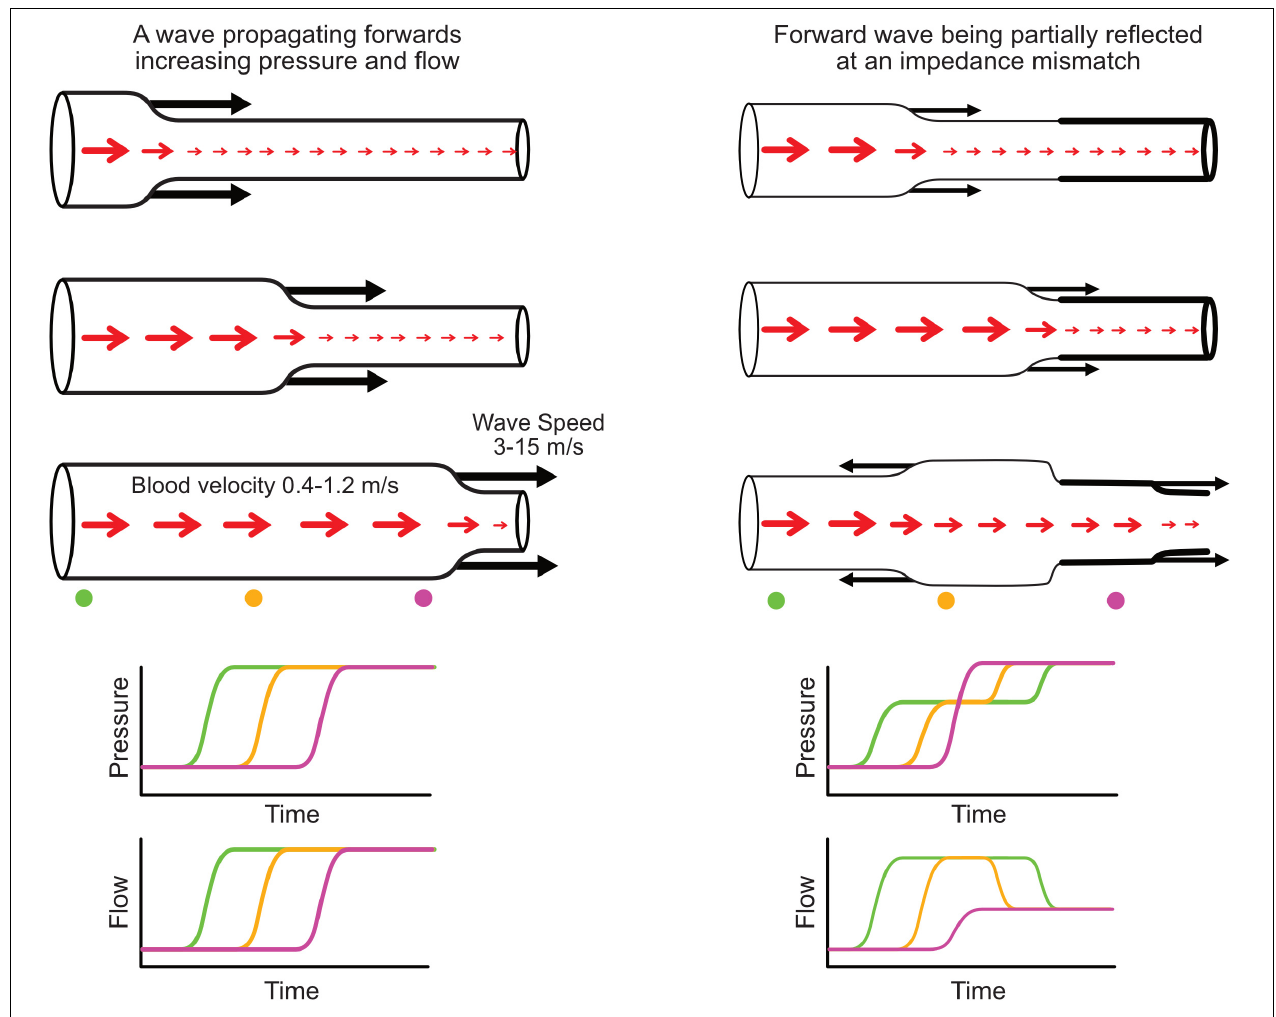
FIGURE 1 | (Left) Illustration of a forward-propagating wave that increases pressure and flow. (Right) A forward-propagating wave encounters an impedance mismatch (increased vessel stiffness indicated by thicker wall) and is partially transmitted and partially reflected. The reflected wave propagates backward and causes a further increase in pressure but a decreased flow. Red arrows indicate blood flow or average blood velocity over a cross-section (larger arrow means higher flow/velocity), while black arrows indicate wave speed and direction of wave propagation. Increased pressure is indicated by increased vessel diameter. Time plots (bottom) indicate the evolution of pressure and flow at three locations along the vessel indicated with color-coded